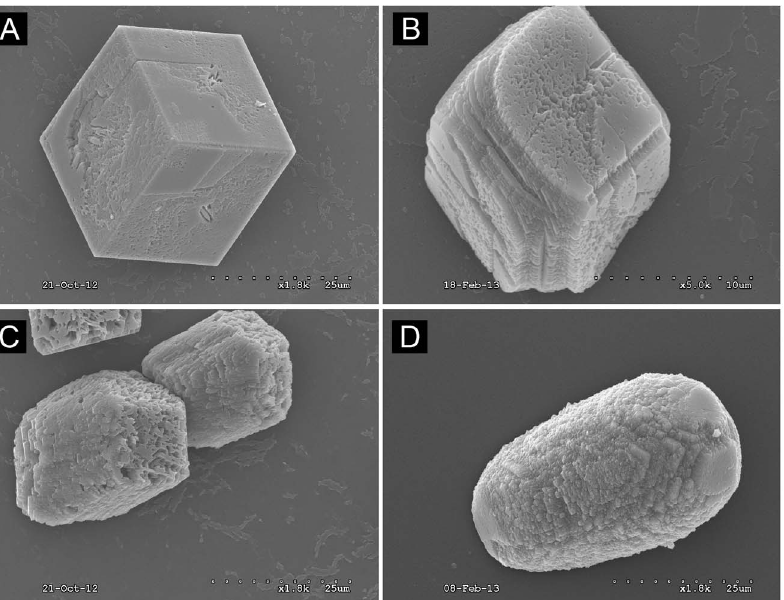
Figure 3. Scanning Electron Microscope Images of calcite modified by rhOtolin-1 alone or in combination with rmOC90. Varying concentrations of rhOtolin-1 and rmOC90 protein, (A) 0 nM rhOtolin-1 and rmOC90; (B) 1000 nM rmOC90; (C) 667 nM rhOtolin-1; (D) 667 nM rhOtolin-1 + 500 nM rmOC90 were dissolved in 7.5 mM CaCl 2 growth solution. Crystals were grown for 48 hours by slow evaporation of NH 4 HCO 3 into growth solution. Crystals were examined with JEOL JSM 6320F Field Emission scanning electron microscopy. Scale Bar, A, C, and D: 25 m m; B: 10 m m.